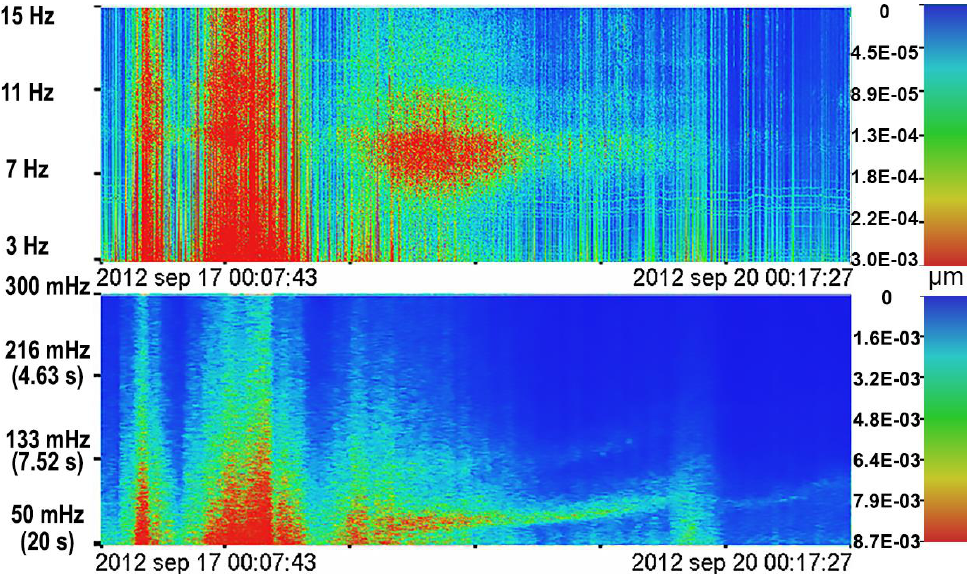
Figure 8. Dynamic spectrograms of laser strainmeter data during influence of Sanba